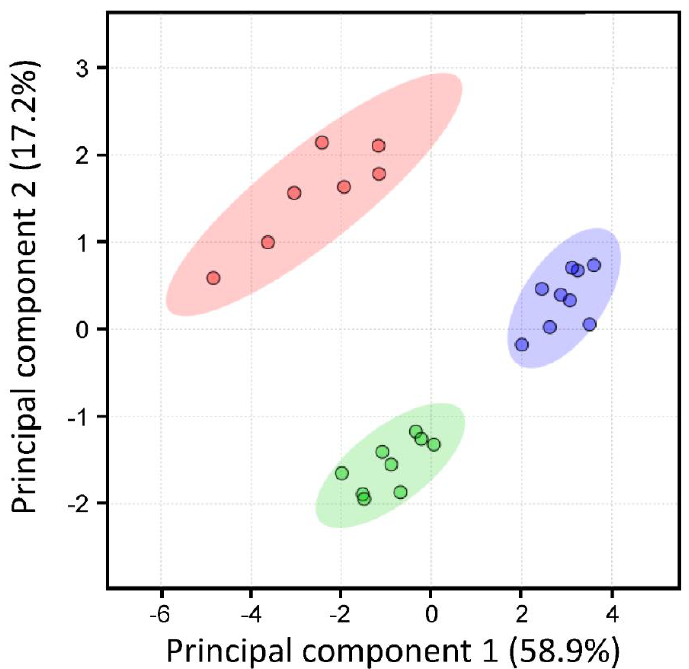
Figure 4. Principal component analysis (PCA) plot showing the similarity relations among Arabidopsis mature seeds from control and octanoyltransferase mutants. These two components explain 76.1% of the variance. Samples from control line are shown as red circles; those from lip2p1 or lip2p2 mutants as green and purple circles,